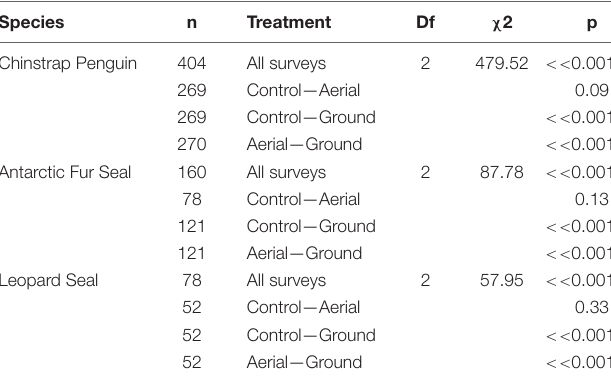
TABLE 5 | Kruskal-Wallis test results comparing Antarctic predator behavioral responses grouped by survey type (levels = Ground, Aerial, Control). Species n